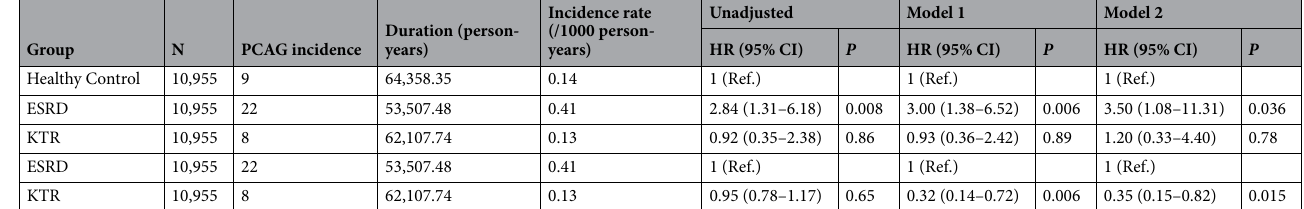
Table 3. PACG incidence in ESRD patients, KTRs, and healthy controls. Model 1: Cox proportional hazard (PH) regression model adjusted for age and sex. Model 2: Cox proportional hazard (PH) regression model adjusted for age, sex, diabetes mellitus, hypertension, dyslipidemia, income, and Charlson comorbidity index. PACG primary angle-closure glaucoma, HR hazard ratio, CI confidence interval, ESRD end stage renal disease, KTR kidney transplantation